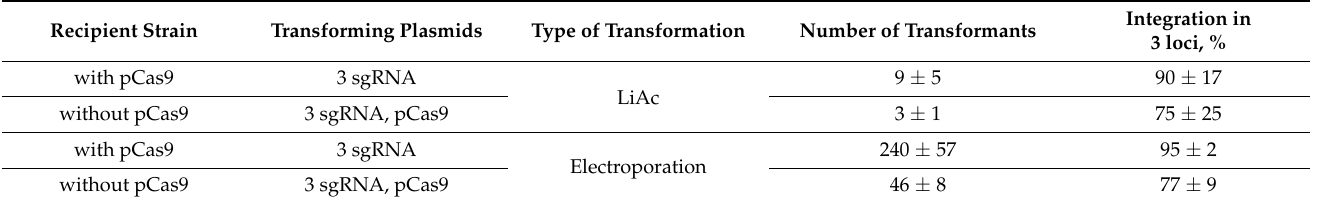
Table 3. The influence of skipping the creation of an intermediate Cas9-expressing strain on the efficiency of integration into three loci.